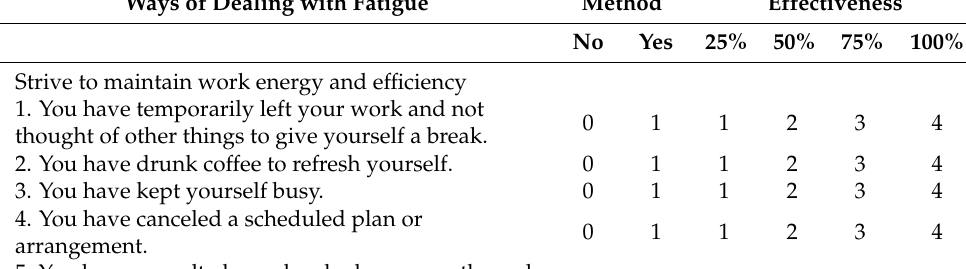
Table 2. The perimenopausal fatigue self-management scale (P-MFSMS). Participants were asked: “Have you used any of the following methods have to deal with your fatigue symptoms? If your answer is ‘yes,’ please provide how effective this method was.” The degree of the effectiveness was categorized as 25% effective = 1 point; 50% effective = 2 points; 75% effective = 3 points; 100% effective = 4